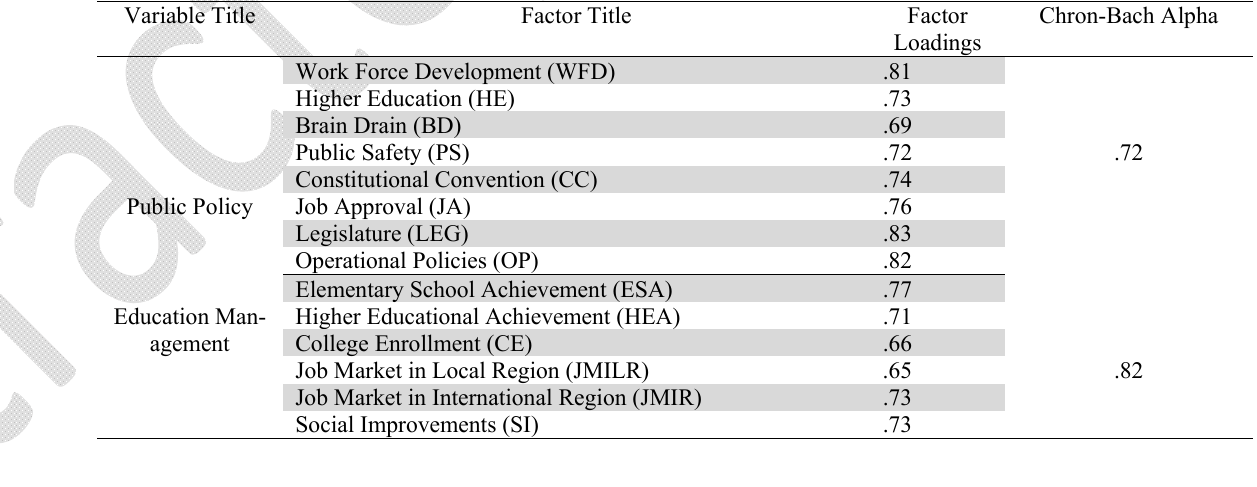
Fig. 1. Structural Model for Public Policy and Education Management Factor Loadings and Reliability Findings